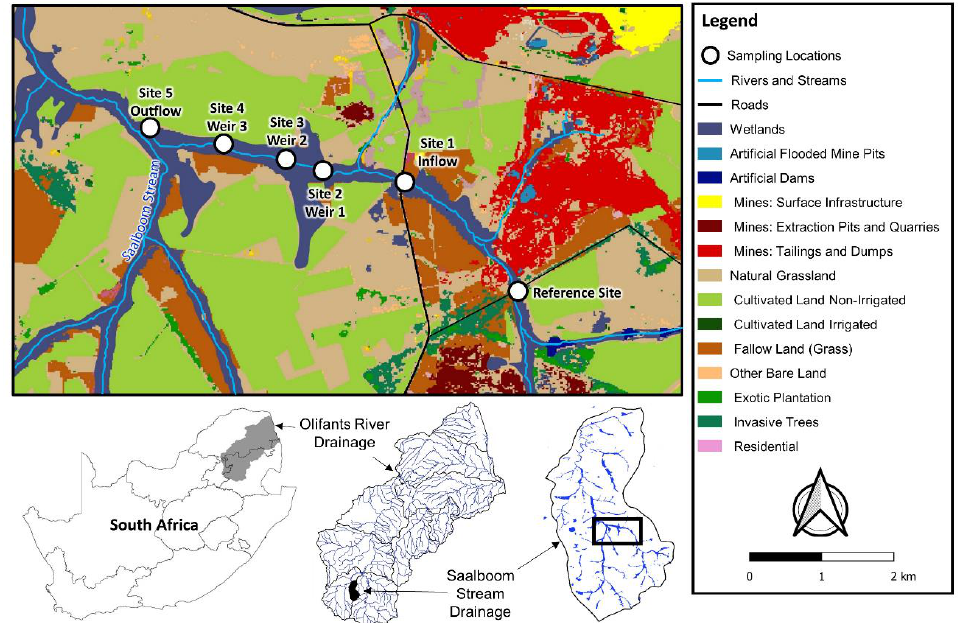
Figure 1. A map indicating the locality and extent of the Grootspruit wetland area. The map also indicates the selected sampling sites monitored over the period 2015 to 2018. The location of the study area within the Saalboom Stream quaternary catchment in the context of the larger Olifants River Basin is also indicated. The map was created with QGIS v 3.12.1 (Open Source Geospatial Foundation Project) also using the SANBI National Wetland Map Project [9] and South African National Land Cover (SANLC) 2020 datasets